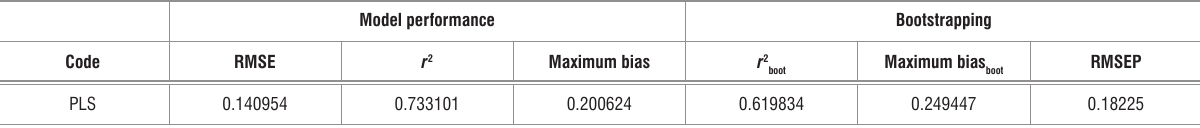
Performance of the partial least squares (PLS) transfer function